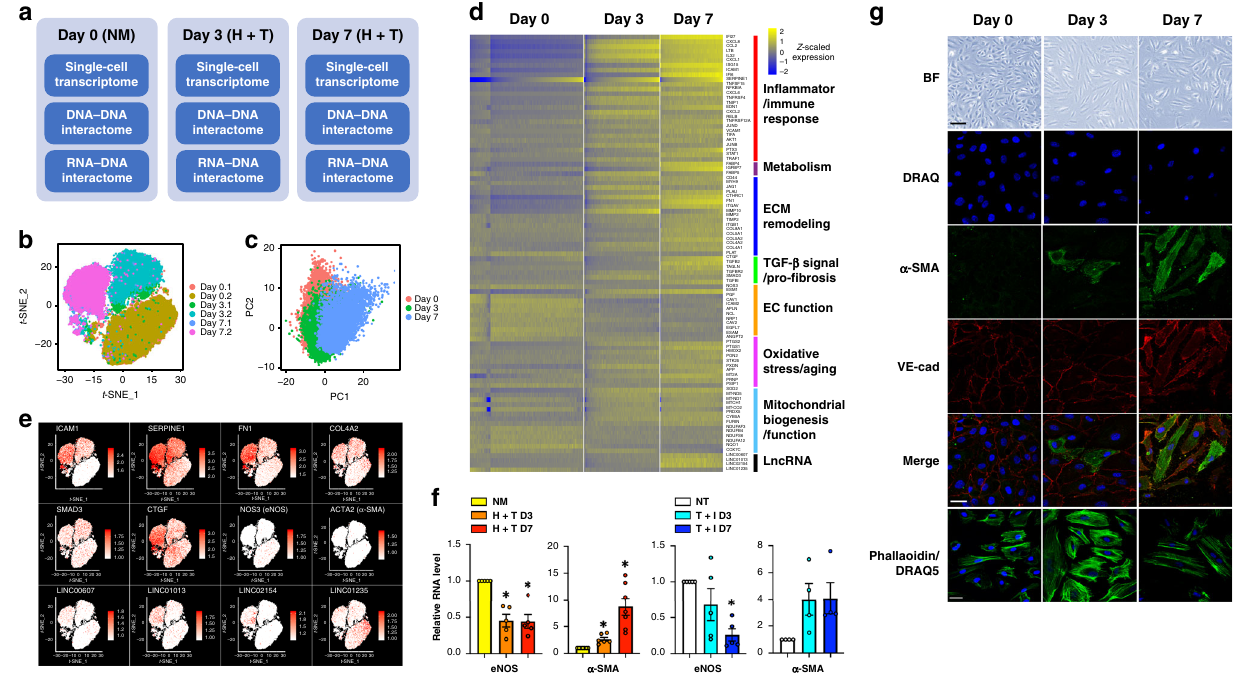
Fig. 1 High glucose and TNF α induce a profound gene expression and phenotypic change. a HUVECs were treated in biological duplicates as Day 0: 25 mM mannitol as normal glucose and osmolarity control (NM); Day 3: combined treatment consisting 25 mM D-glucose and 5 ng/mL TNF α (H + T) for 3 days; and Day 7: H + T treatment for 7 days. Each group of treated cells was subjected to single-cell RNA-seq (scRNA-seq), Hi-C, and iMARGI assays. b t -SNE plot of scRNA-seq (4000 – 15,000 cells per sample) showed clear separation by treatment condition into three distinct clusters. c Principal component analysis of scRNA-seq data: single cells are plotted in the fi rst two PC space and are labeled in red (Day 0, i.e., NM), green (Day 3, i.e., 3-day H + T treatment), and blue (Day 7, i.e., 7-day H + T treatment). d Expression heatmap ( z -scaled) of top DE genes in single ECs grouped into functional pathways. Cells were ordered by increasing SERPINE1 expression (per each sample separately) and binned per 100 cells for the analysis. A total of 269 bins in Day 0, 177 bins in Day 3, and 148 bins in Day 7. e t -SNE plots of the expression level of selected genes in each single cell across the time course. The RNA levels are represented by log-normalized unique molecular identi fi er counts. f mRNA levels of eNOS and α -SMA in NM vs. H + T-treated HUVECs and cells untreated (NT) or treated with TGF- β (10 ng/mL) and IL-1 β (5 ng/mL; T + I) for 3 or 7 days. The respective control was set as 1. Relative eNOS level: data represent mean ± SEM from fi ve independent experiments; relative α -SMA level in H + T treatment: data represent mean ± SEM from seven independent experiments; relative α -SMA level in T + I treatment: data represent mean ± SEM from four independent experiments. * P = 0.0067, 0.0087, 0.0057, and 0.0017 from left to right based on ANOVA with Bonferroni as post hoc test. g Cell morphology under bright fi eld (BF), immuno fl uorescent staining of α -SMA, and VE-cadherin (VE-cad), phalloidin staining of cytoskeleton, and DRAQ5 (DRAQ) staining of the nuclei. Representative images from fi ve independent experiments are shown. Scale bar of BF = 100 µ m; scale bars of (immuno) fl uorescent staining = 50 µ m. Source data are provided as a Source data fi